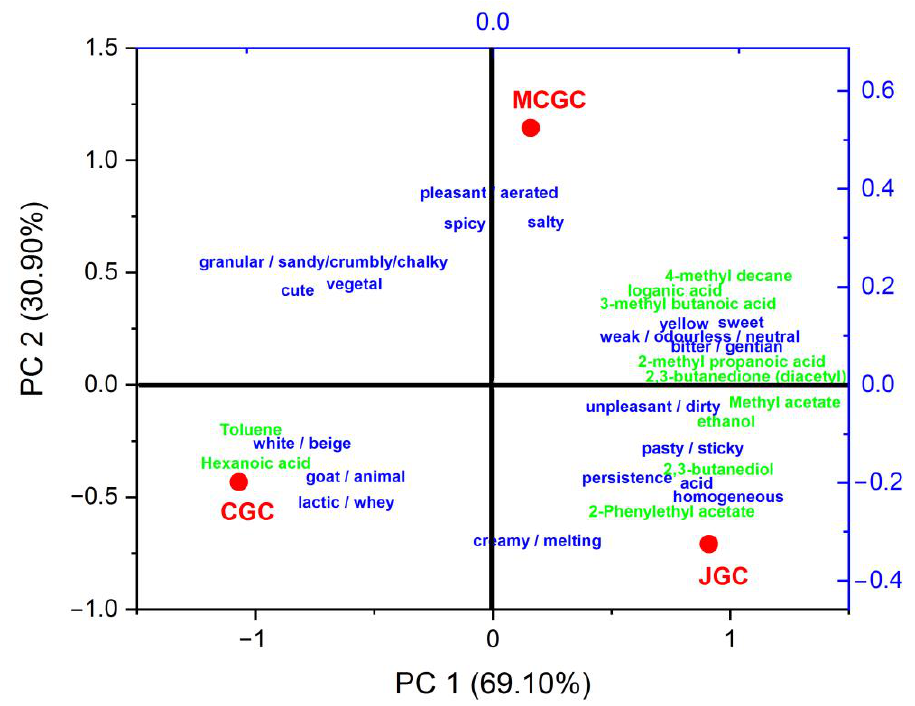
Figure 4. Biplot representation of the principal component analysis of the non-flavored GCG and flavored goat cheeses JGC and MCGC (red legend) based on their sensory and chemical characteristics. Loadings of the PCA model represent the number of citations of free descriptors (blue legend) associated with unflavored and gentian flavored goat cheeses (citations cited at least twice) and the relative contents of the ten volatile compounds (green legend) statistically differentiated among the three typologies of goat cheeses.